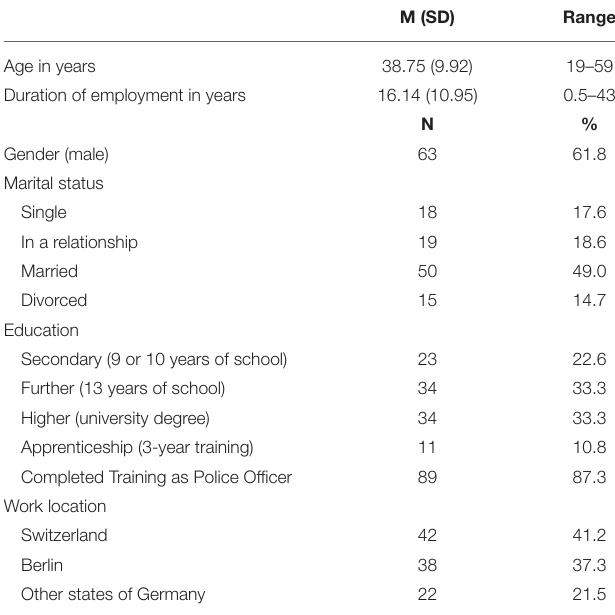
TABLE 1 | Characteristics of participants ( N =